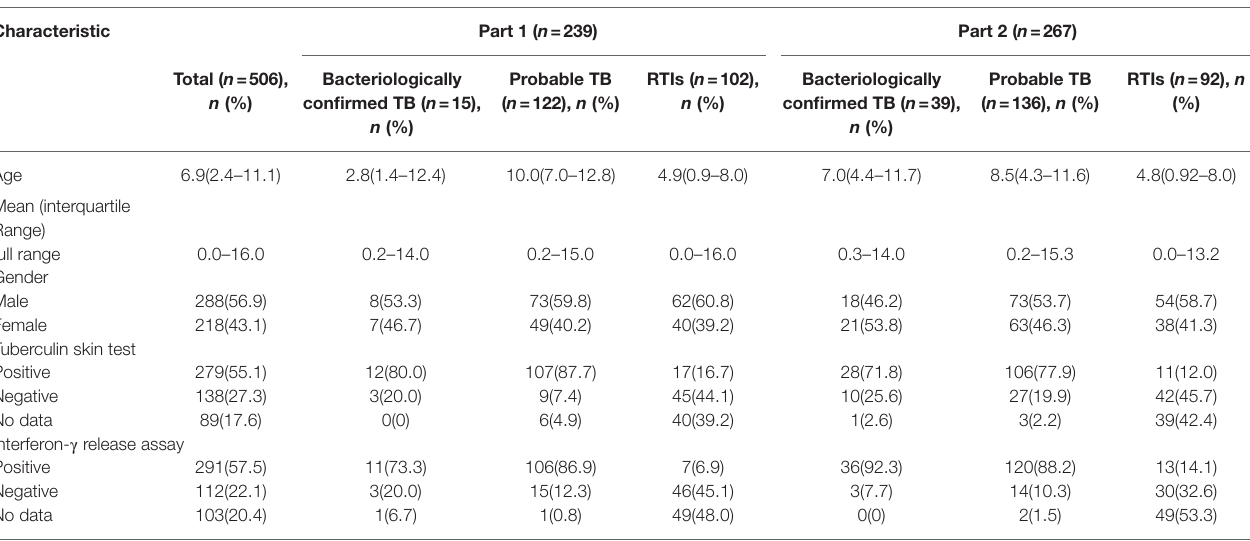
TABLE 1 | Main clinical characteristics of the study